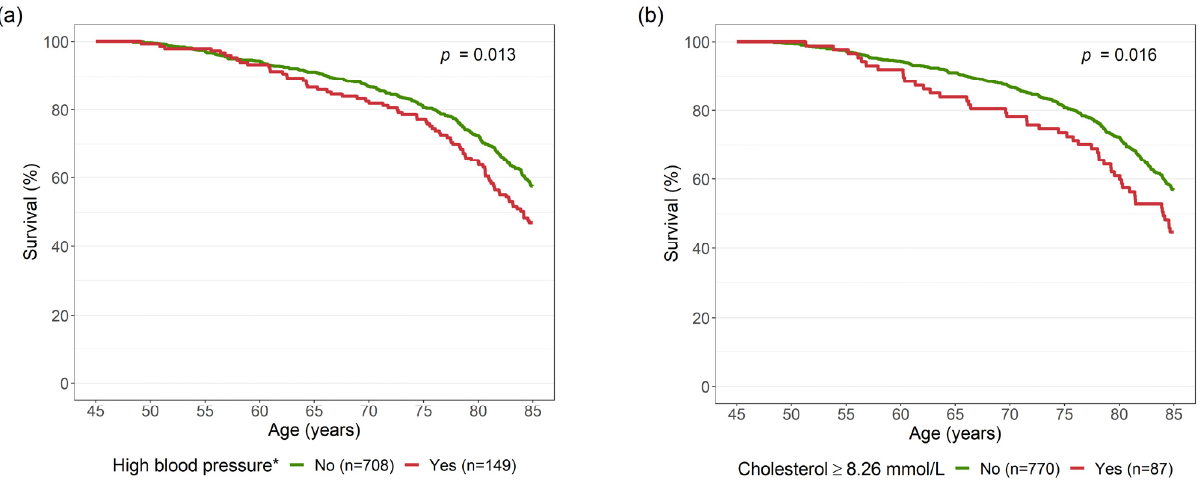
Figure A2. Survival curves by high blood pressure * ( a ) (systolic blood pressure ≥ 140 mmHg and diastolic blood pressure ≥ 90 mmHg, or blood pressure medication) and high cholesterol ( b ) ( ≥ 8.26 mmol/L, i.e., the 90% quantile). The Tromsø Study 1979–2019. Table A2. Hazard ratios for all-cause mortality from a multiple Cox model with risk factors observed at age 45–49 years (Tromsø2). The Tromsø Study 1979–2019. Risk Factor Hazard Ratio 95% Confidence Interval p ‐ Value